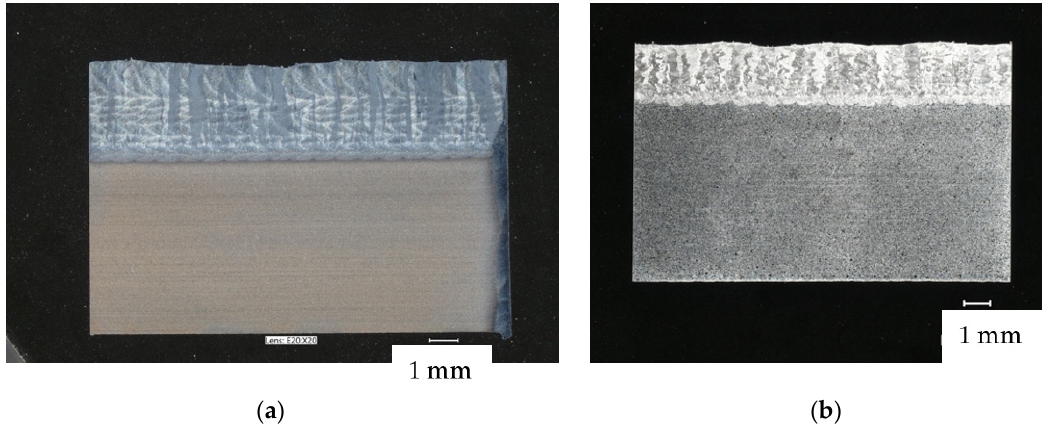
Figure 5. Cross-sections of ( a ) Ti-6Al-4V and ( b ) IN-718 AM depositions on baseplate. Table 1. Process parameter sets for DED-AM builds. Table 3. Profilometer-measured surface